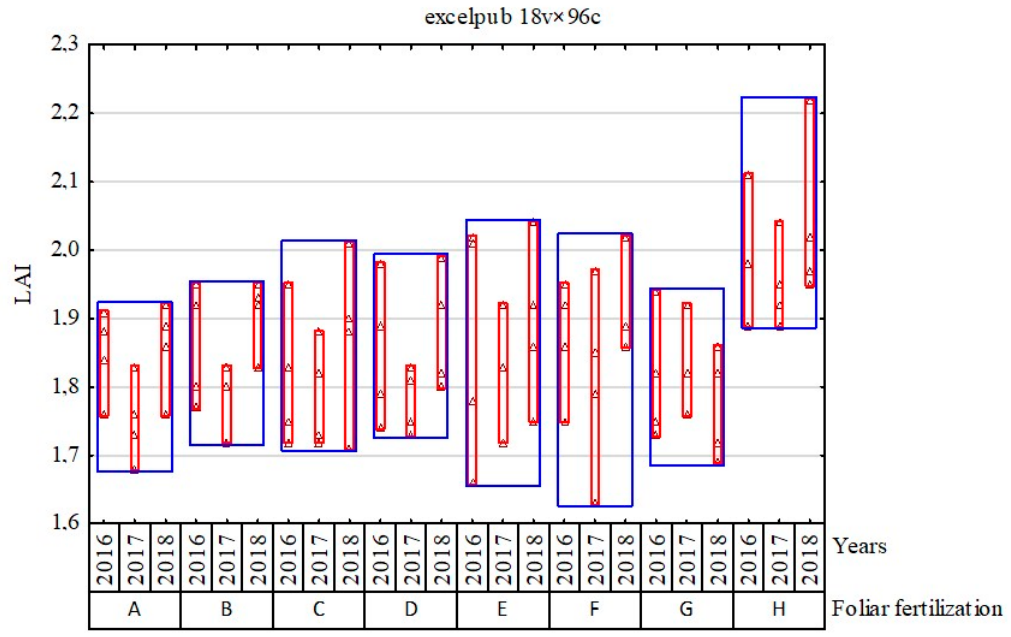
Figure 3. Leaf area index (LAI). Description in Table 1.